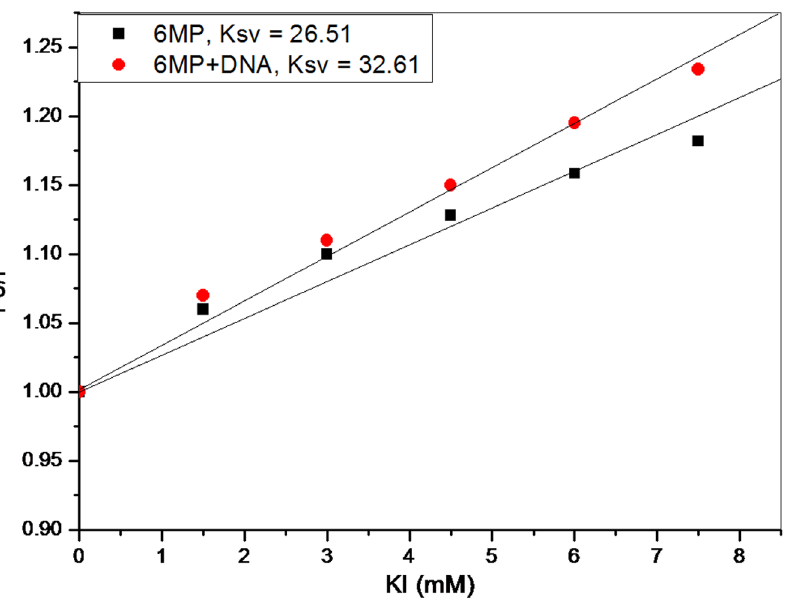
Figure 5. KI quenching experiment. Stern-Volmer plot for fluorescence quenching of 6MP (50 m M) by KI in absence and presence of CT-DNA (100 m M). Quenching of 6MP fluorescent intensity was done using KI in absence and presence of CT-DNA and quenching constant was calculated in both the case. Difference in Ksv value was further used to investigate the binding mode of 6MP and DNA.